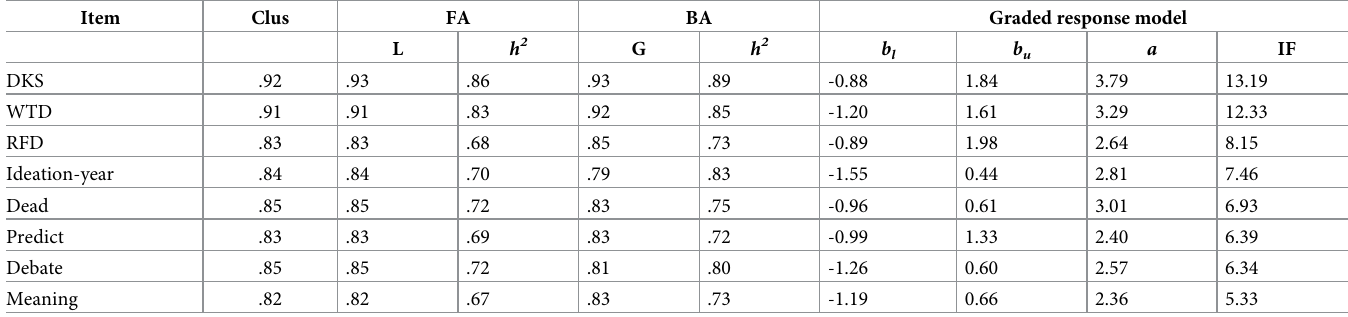
Table 3. Suicidality Scale item statistics (sample 1, N =